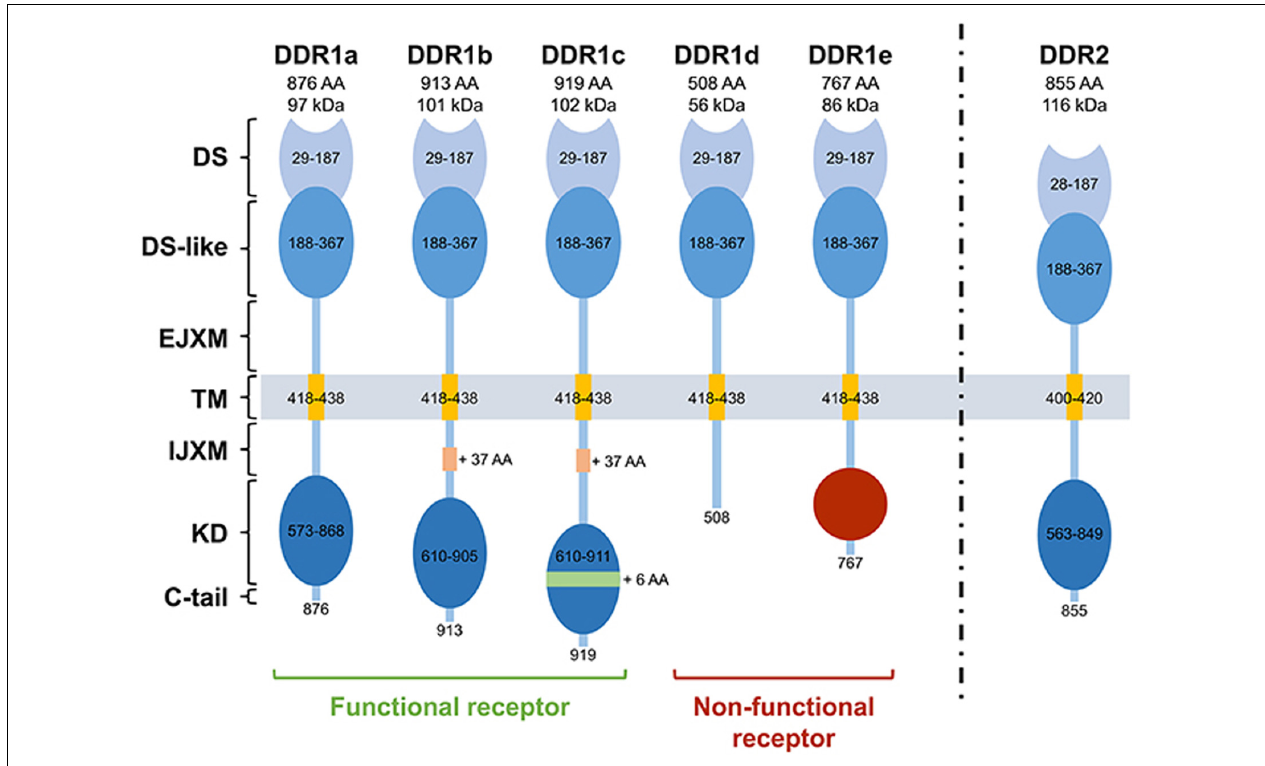
FIGURE 3 | The structure of DDRs. DDR1a, DDR1b, DDR1c, and DDR2 are enzymatic active receptors, and DDR1d and DDR1e are inactive kinase-deficient receptors. DS, discoidin domain; DS-like, discoidin-like domain; EJXM, extracellular juxtamembrane region; TM, transmembrane segment; IJXM,